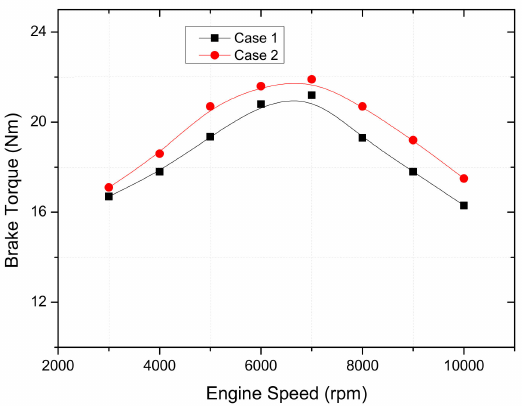
Figure 11. Comparison of brake torque between the original and new valve mechanism.